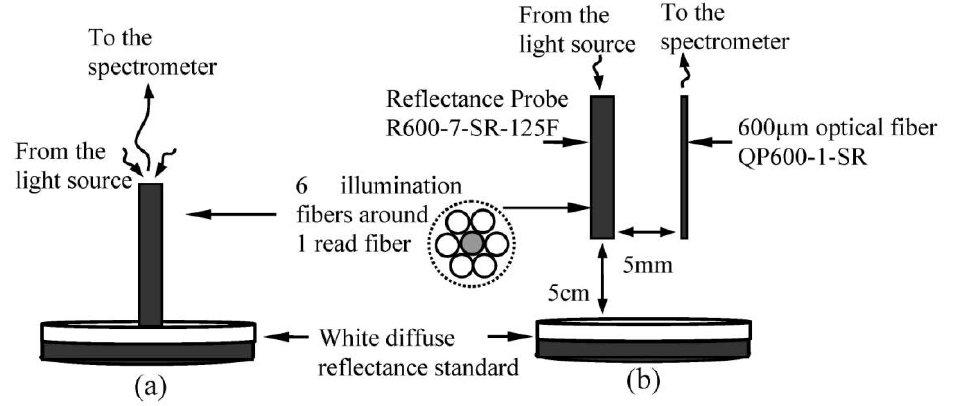
Figure 1. Probe configuration for ( a ) Reflectance calibration setup ( b ) interactance calibration setup.